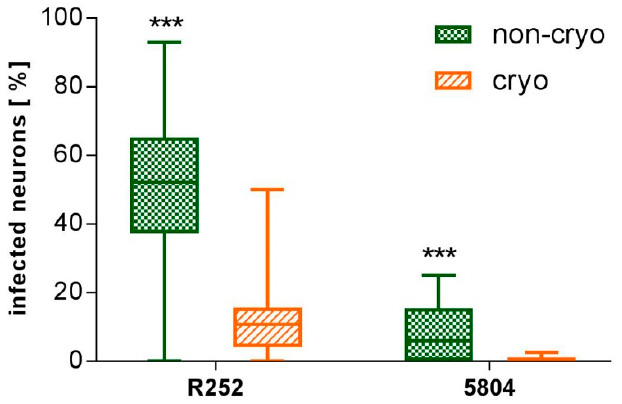
Figure 4. Y axis: neurons infected with different CDV strains [%] at 6 dpi. Cryo neurons show reduced susceptibility to infection with both CDV-strains (CDV R252 and CDV-5804 PeGFP) when compared to non-cryo neurons. Generally CDV R252 infects a higher percentage of neurons than CDV-5804 PeGFP. Non-cryo and cryo: n = 24 wells. *** = p < 0.001. Employed statistical test: Mann–Whitney U-test., dpi = days post infection, non-cryo = non-cryopreserved, cryo = cryopreserved, CDV = canine distemper virus, eGFP = enhanced green fluorescent protein. Graphs show median value, quartils, minimum and maximum values.